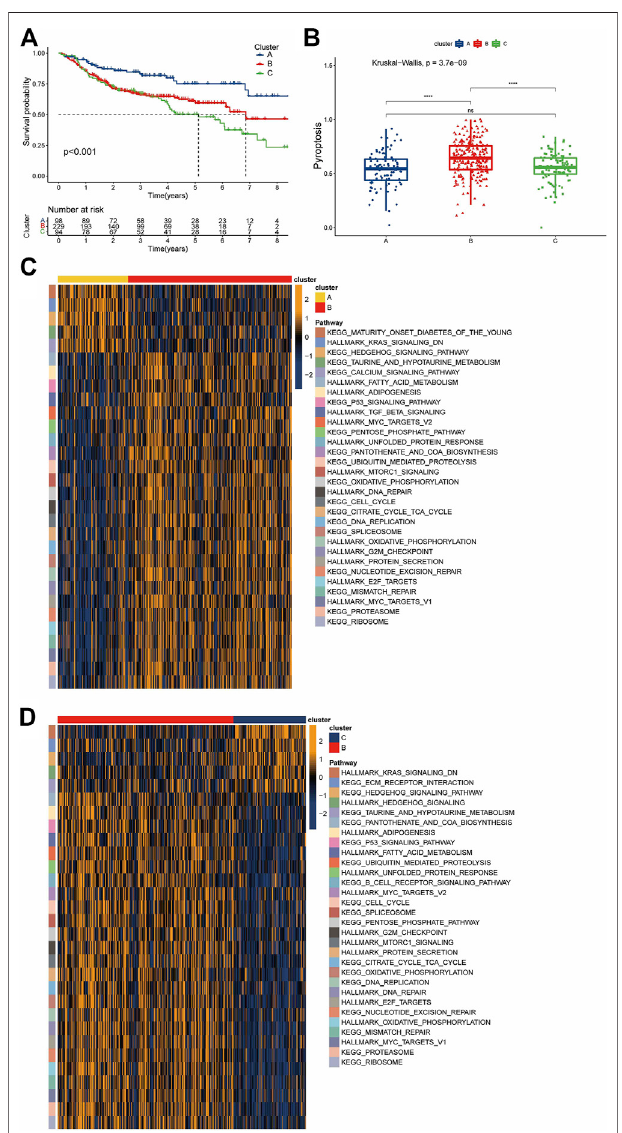
FIGURE 3 | Pyroptosis-associated clusters and differences in biological features. (A) Kaplan-Meier survival plots for the three pyroptosis-related clusters. Blue represents cluster A, red cluster B, and green cluster C. (B) Pyroptosis signature score differences among the three clusters. Blue represents cluster A, red cluster B, and green cluster C. (C,D) The results of a GSVA enrichment analysis are shown as a heatmap. The bars at the top represent different clusters. The square color blocks of different colors on the right correspond to the left most color block, which represents different paths. In the heatmap, yellow represents pathway activation, and dark blue represents pathway inhibition.